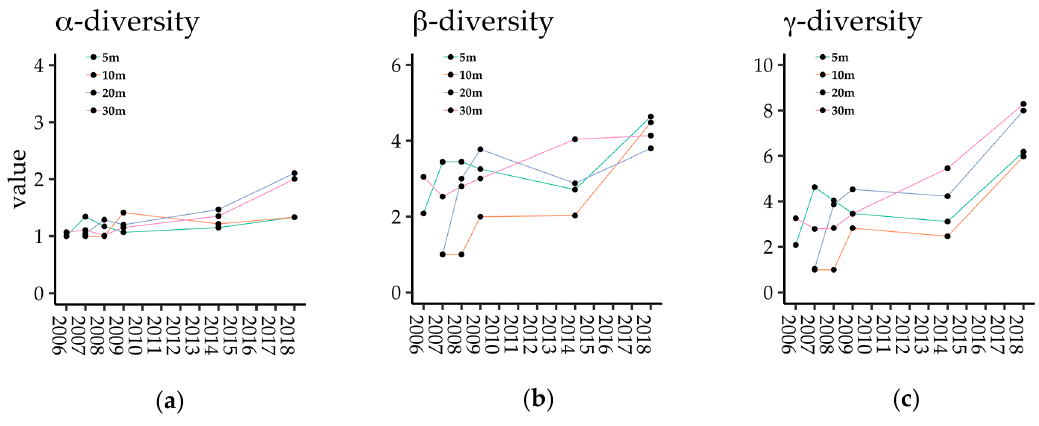
Figure 3. Temporal changes in ( a ) α -, ( b ) β -, and ( c ) γ - diversities in each plot.